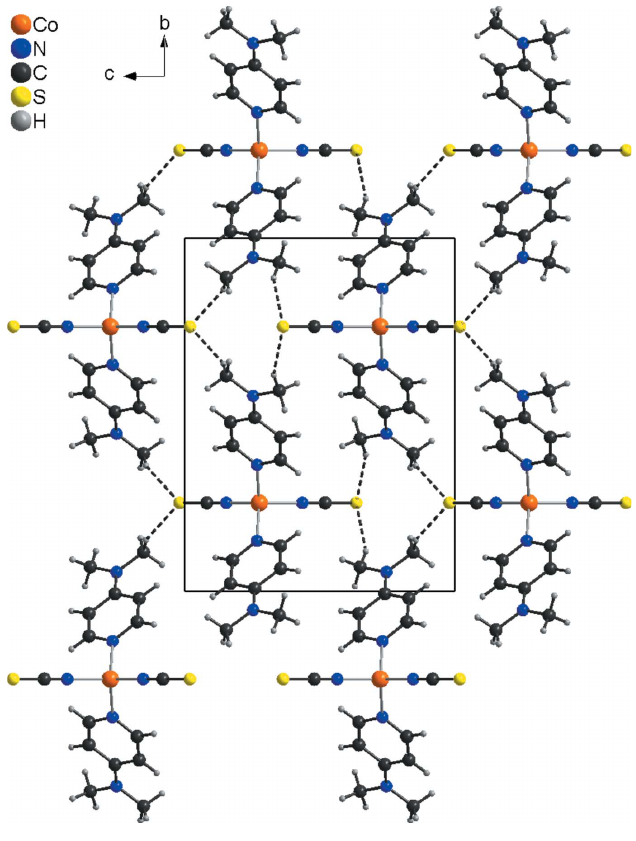
Figure 3 Crystal structure of form I with a view of a layer in the direction of the crystallographic a- axis. Intermolecular C—H (cid:2)(cid:2)(cid:2) S hydrogen bonding is shown as dashed lines.